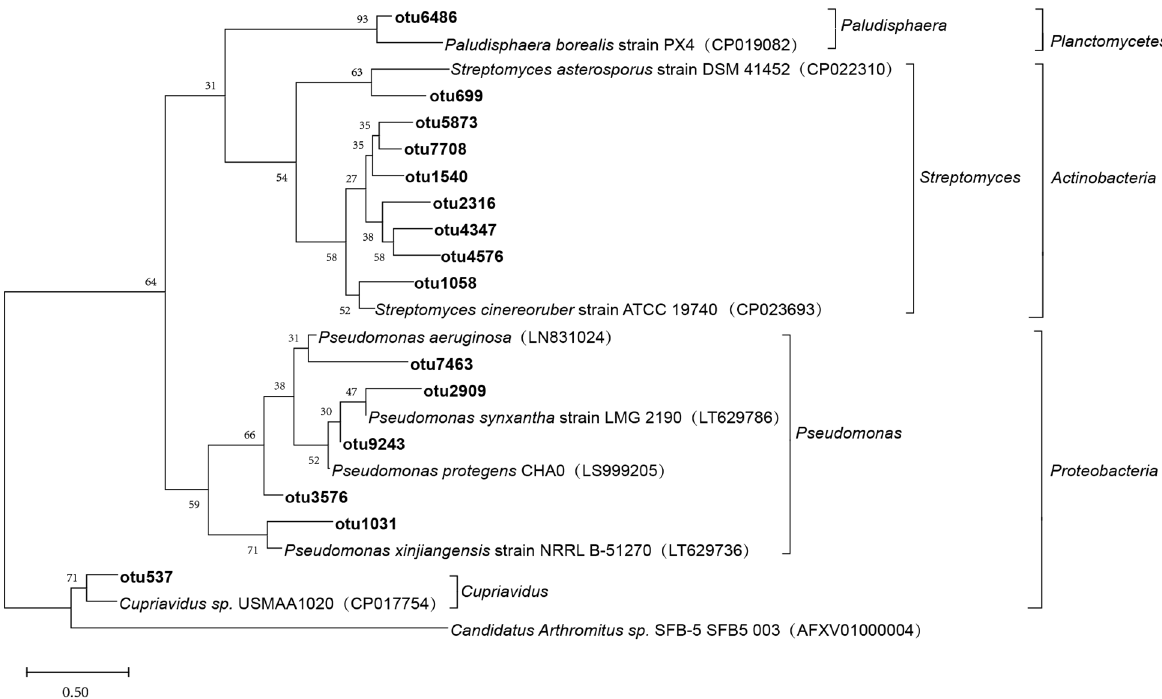
Figure 2. Phylogenetic tree of PhoD gene sequences (15 OTUs) from sediments of the Sancha Lake.